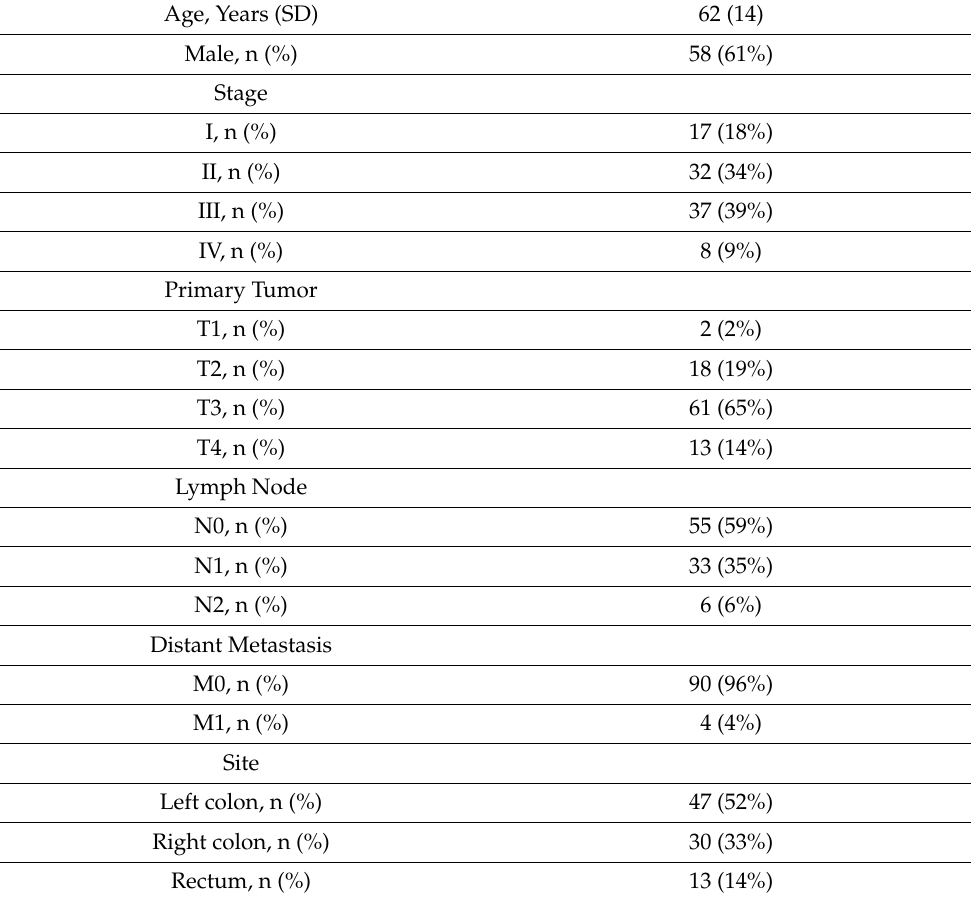
Table 1. Clinicopathological features of CRC